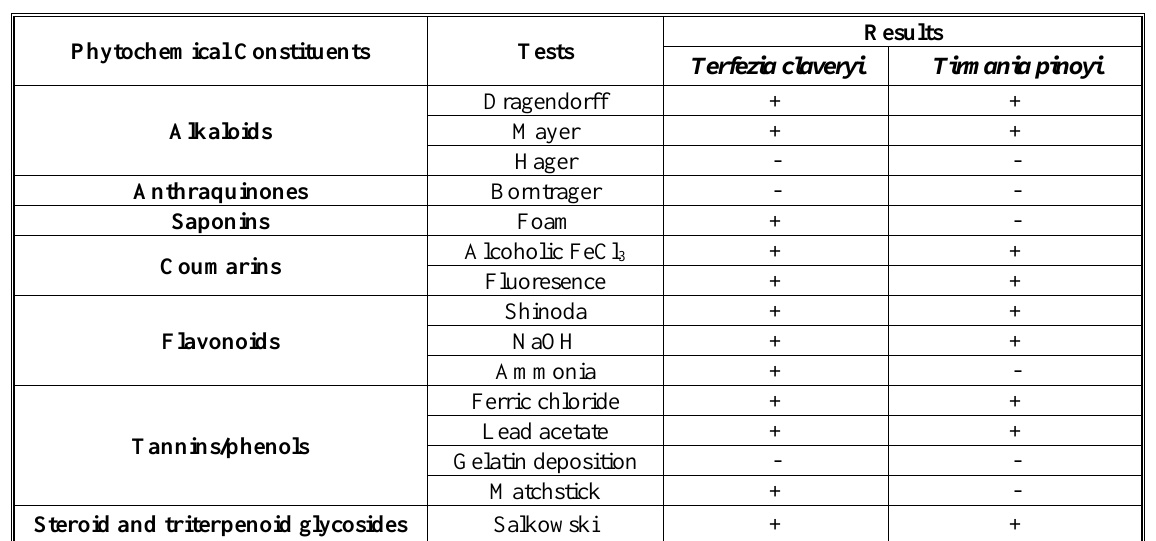
Figure 2.An ascocarp of Tirmania pinoyi and a cross section of it. Table 1. Detection of phytochemical components for two species of truffle: Terfezia claveryi and Tirmania pinoyi